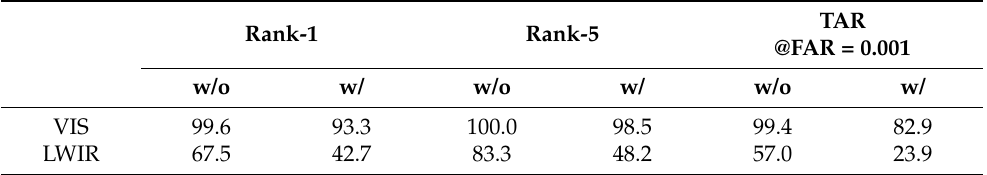
Table 3. Results (in %) with and without FNM on the TUFTS-Exp database, using the Light CNN-29 and cosine similarity score. Rank-1 Rank-5